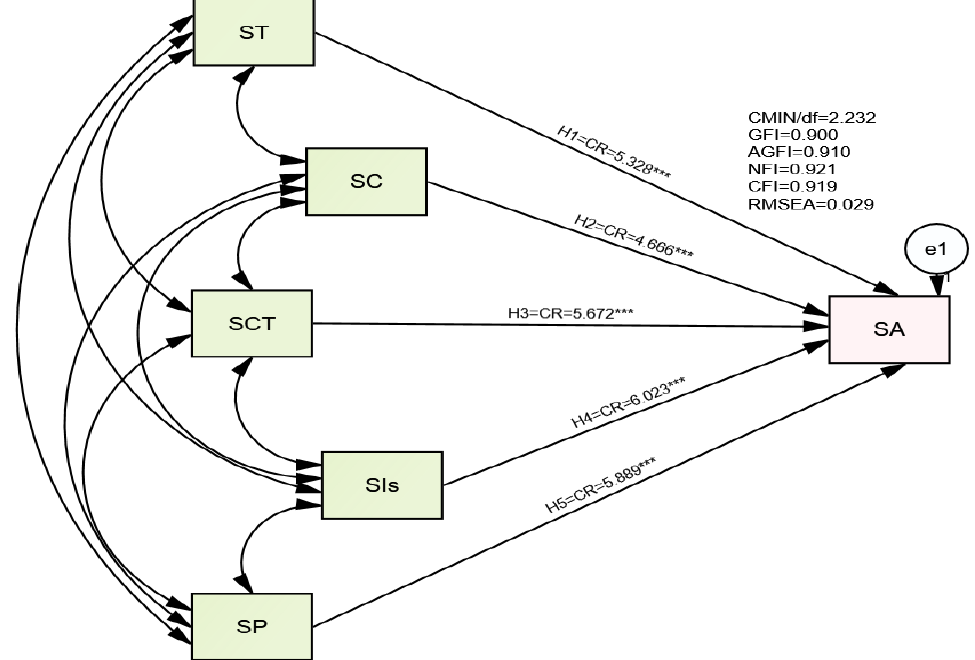
Figure 2. Path Analysis. Source: Authors’ own estimation. Note: CR = critical ratio; *** p = significance level at <0.01. Note(s): ST = safety training; SC = safety communication; SCT = safety commitment; Sis = safety incentives; SP = safety policy; SA = safety accountability.